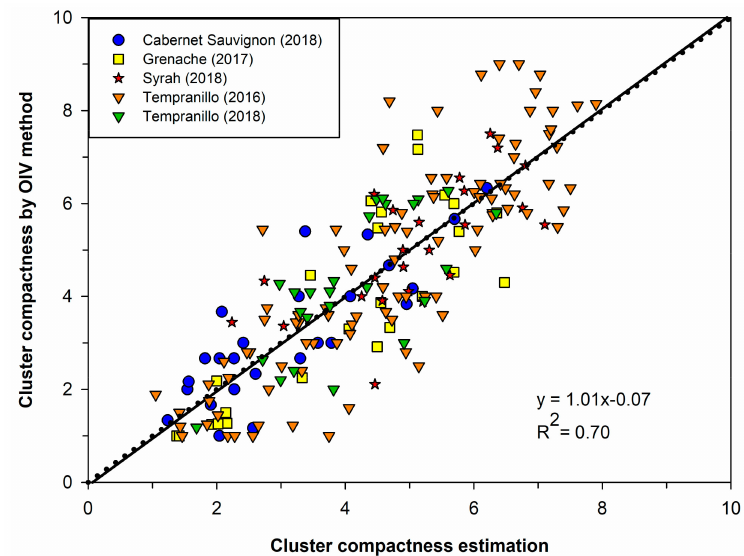
Figure 8. Performance of the GPR model performing leave-one-out cross validation (LOOCV) on the whole data (195 clusters); correlation between the cluster compactness estimation performed by the model and the OIV ratings (reference method) evaluated visually by the panel of